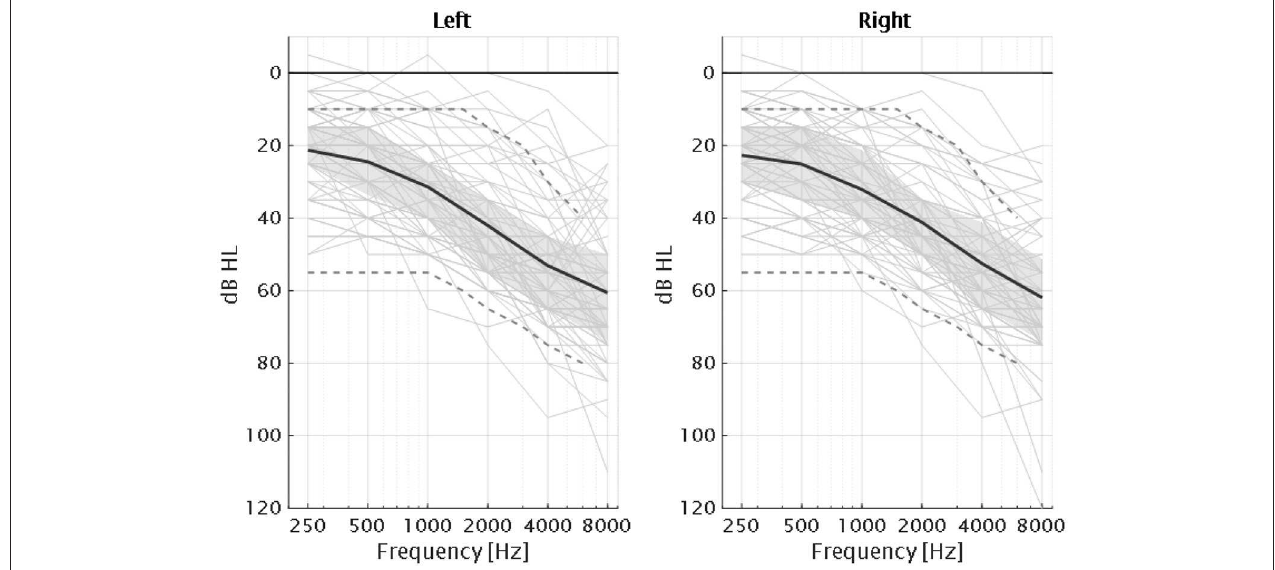
TABLE 4 | Summary of the results of the extended audiometry for high frequencies eAUD-HF.